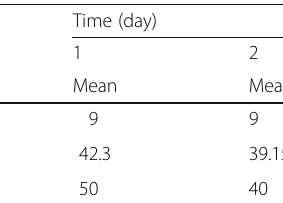
Table 1 Analyses of 25-OH vitamin D stored at room temperature for 1 and 2 days